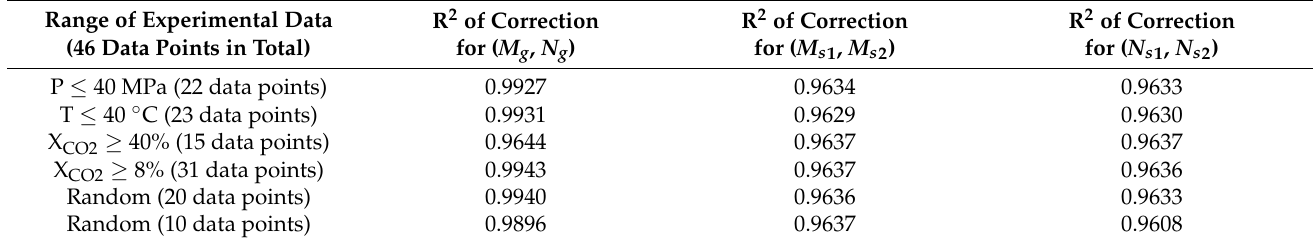
Figure 8. Comparison of model calculation results and experimental data (Ratnakar [35]): ( a ) before correction; ( b ) after correction. Table 3. Comparison of correlation coefficients (R 2 ) of different correction parameters.